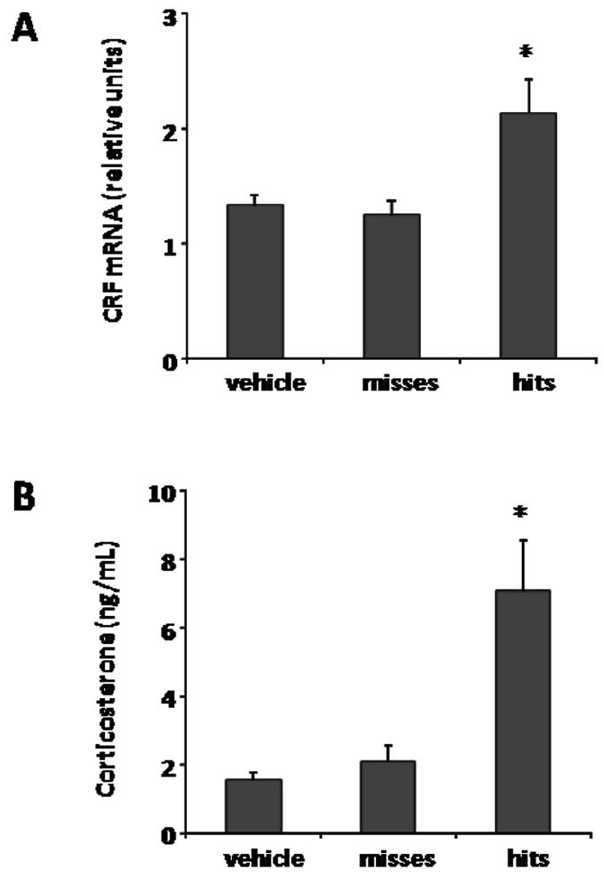
Figure 6. Ghrelin microinjection into the PVN activates the HPA axis. Panel A shows comparative values of RT-qPCR for CRF mRNA in the PVN micro-dissected punches obtained from intra-PVN ghrelin- treated, intra-PVN vehicle-treated and misses groups. Data is shown as mRNA levels of CRF relative to the housekeeping gene Cyclophilin A, calculated by the comparative threshold cycle (Ct) method. Panel B shows comparative values of specific ELISA for plasma corticosterone obtained from intra-PVN ghrelin-treated, intra-PVN vehicle-treated and misses groups. Data represent the mean 6 SEM. *p # 0.05.